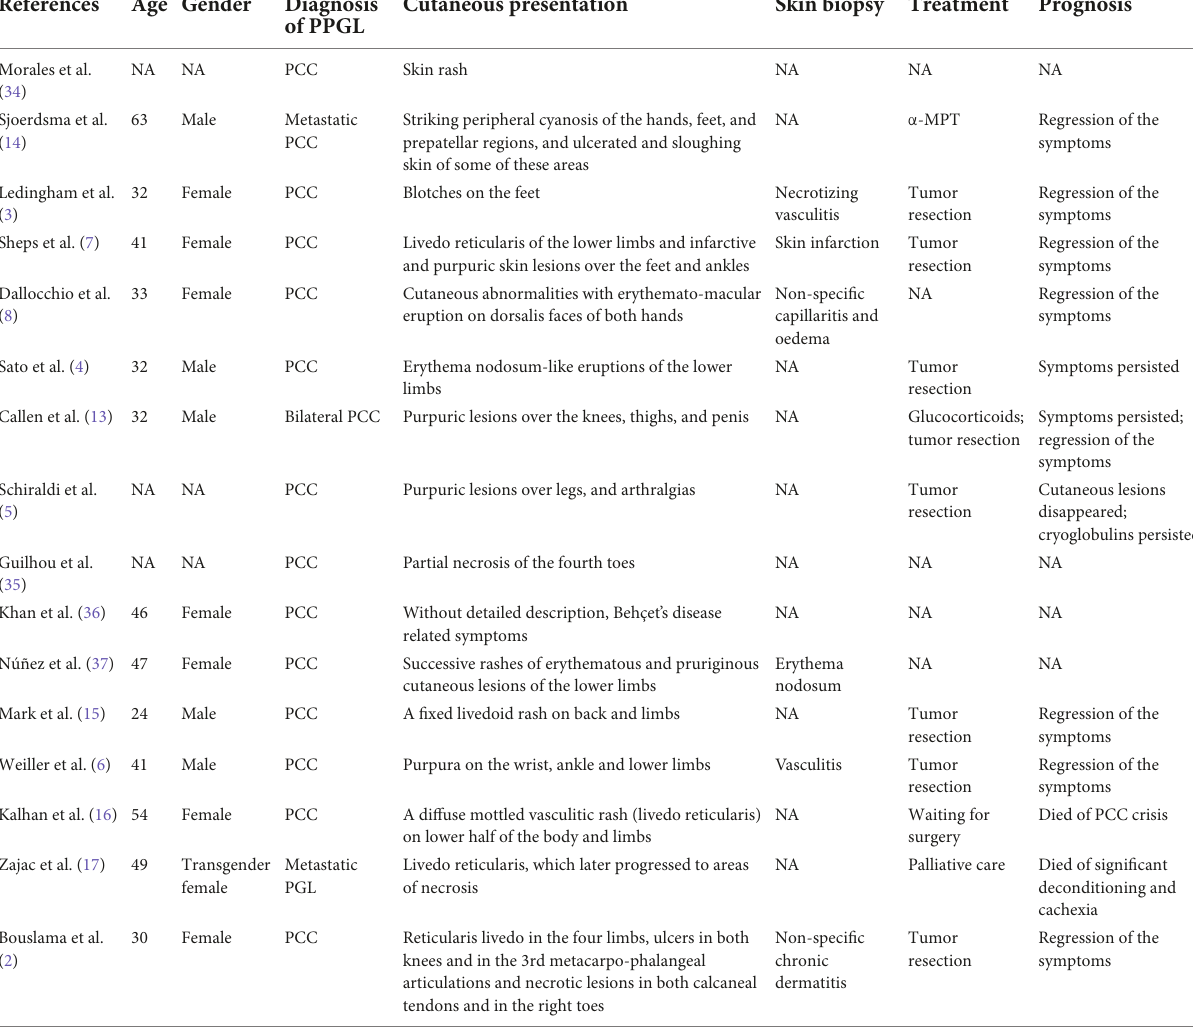
TABLE 1 Summary of the cases of pheochromocytoma/paraganglioma with cutaneous involvement in the